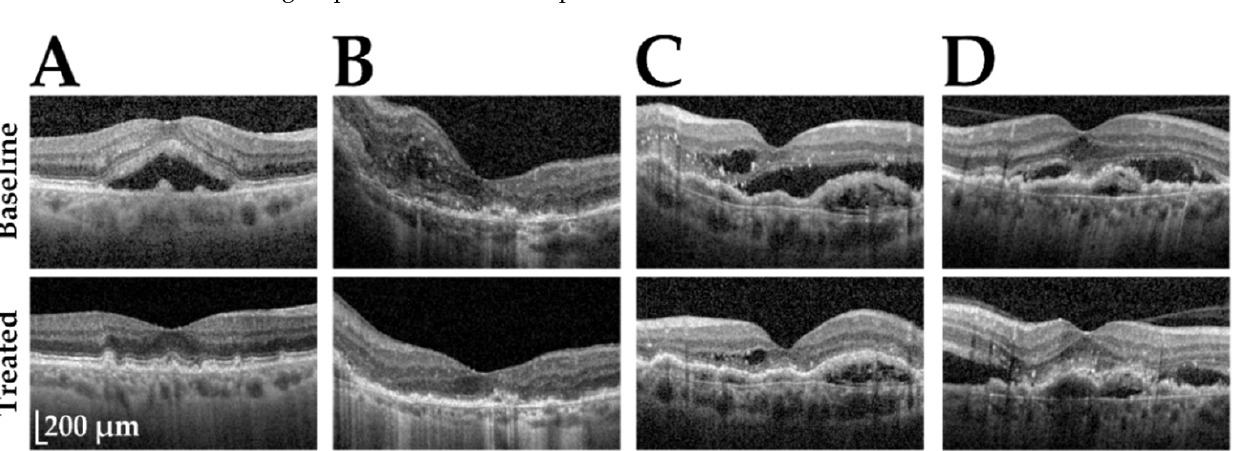
Figure 1. Exemplary optical coherence tomography (OCT) images of nAMD patients and their categorization according to treatment responses. Shown are the OCT images of four patients ( A – D ) before (baseline) and after treatment (treated). Individuals in ( A ) and ( B ) were assigned to the responder group, while probands in ( C ) and ( D ) were more complex in their response to treatment. The individual in ( C ) was categorized as a responder due to morphological improvements (101 µm decrease in central retinal thickness) and a strong improvement of visual acuity (gain of 0.3 log- MAR), although a dry retina was not achieved during the treatment period. The patient in ( D ) was not responsive to the treatment and was assigned as a non-responder.